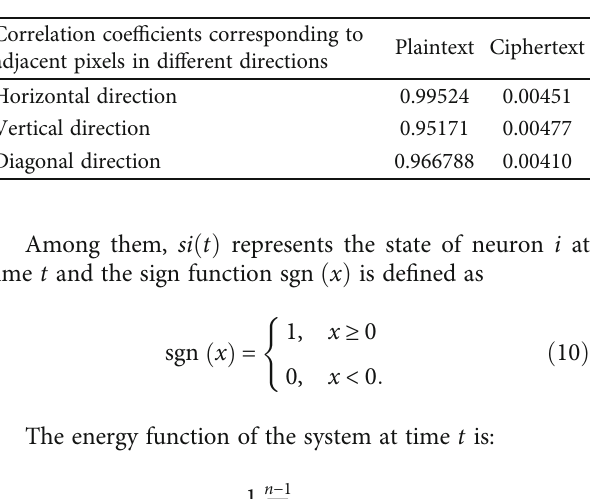
Table 2: Correlation of adjacent pixel pairs before and after image